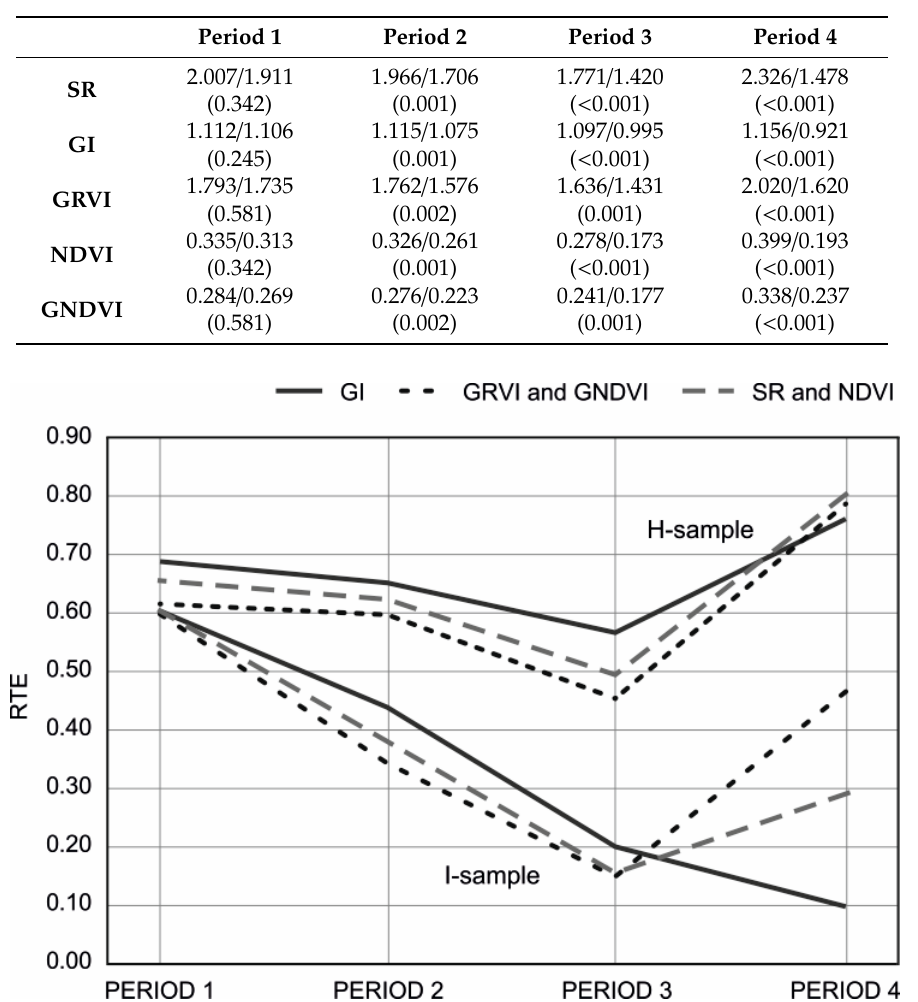
Table 2. Comparison of median values in the H-sample / I-sample (p-values of Mann–Whitney test in brackets). Note: The resulting p-values for GRVI and GNDVI, as well as for SR and NDVI, were identical in these non-parametric test procedures due to the definition of the indices (see Table 1).